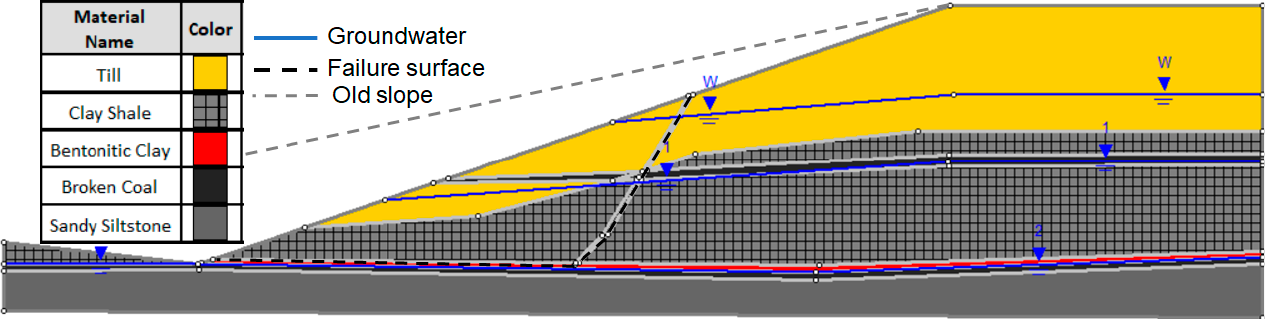
Figure 2. Geotechnical section sketch (not to scale) of the Devon landslide—adapted from [10].